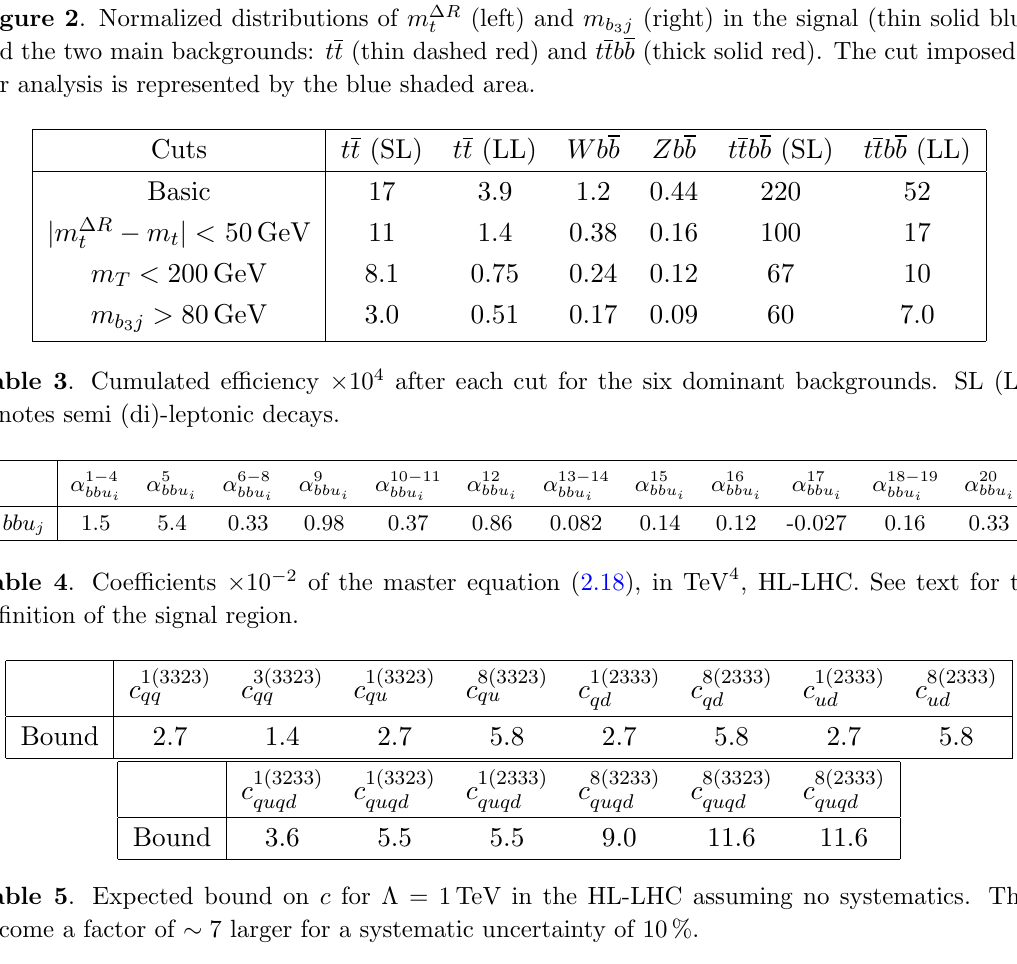
(left) and m b (right) in the signal (thin solid blue) t 3 j